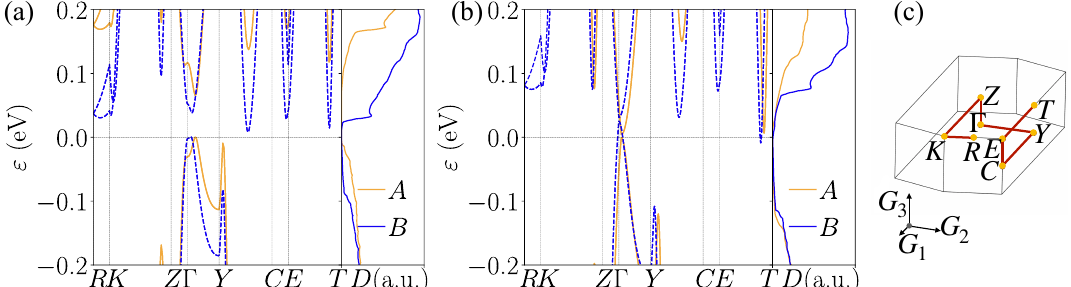
Figure 3: (a) Band structure and density of states (DoS) for structural models A and B . (b) Bands and DoS close to the topological phase transition induced by uniaxial strain. The apparent different size of the electron and hole Fermi surface pockets visible close to the transition in model B is compensated by the larger number of electron pockets and their larger elongation along the direction G